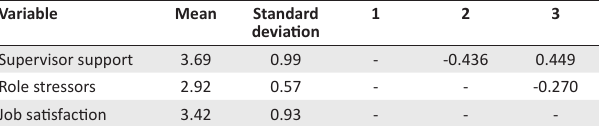
TABLE 7: Means, standard deviations and intercorrelations for supervisor support, role stressors and for job satisfaction. Variable